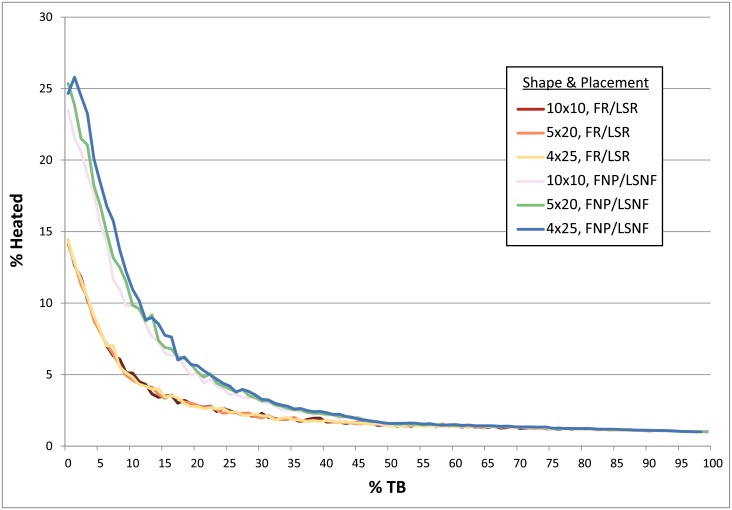
Chart comparing same-sized occupation surfaces of different shapes (i.e. degree of elongation) and different hearth and lithic placement scenarios.Parameters: 1 fire, fire size 1, 4 lithic scatters, 30 occupations, 0–100% TB, 1% introduced lithics. FNP = Fire near previous, FR = Fires random, LSNF = Lithic scatters near fire, LSR = Lithics scatters random, TB = Thermal buffering.